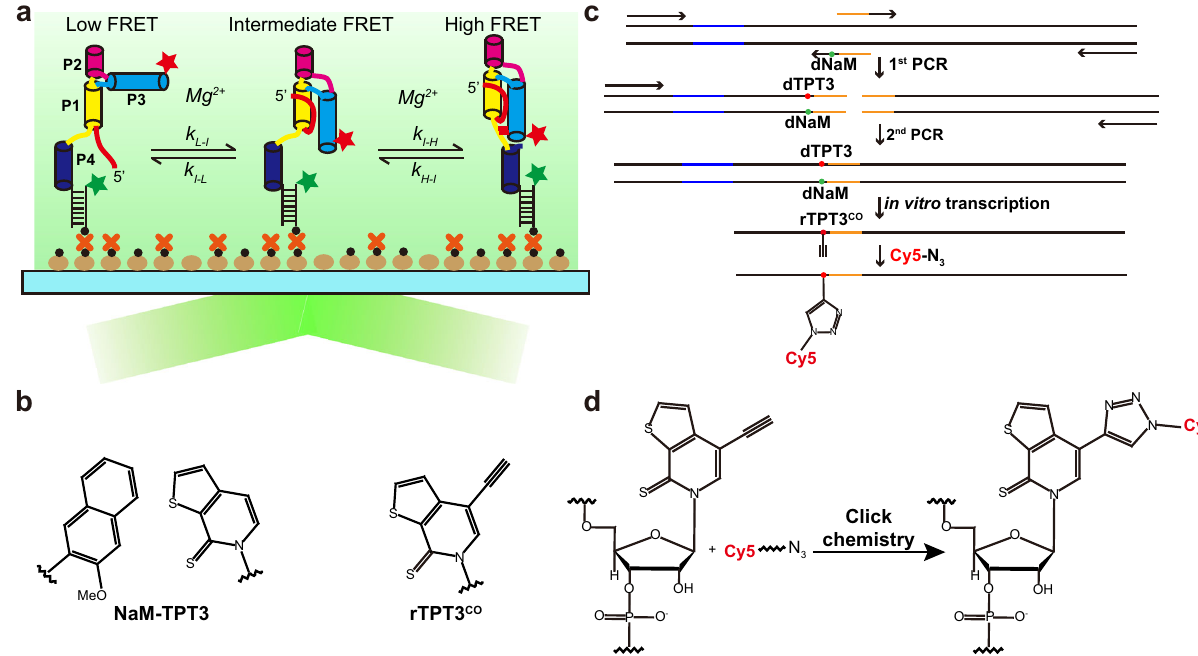
Fig. 2 UBP-based strategy for RNA fl uorescent labeling facilitates TIRF-based smFRET measurements of fl aviviral xrRNAs. a Schematic representation of the TIRF-based smFRET analysis of the folding of fl aviviral xrRNAs. The low-FRET ( L state ), intermediate-FRET ( I state ), and high-FRET ( H state ) states correspond to the unfolded, partially folded, and folded states of xrRNA1, respectively. b Chemical structures of the parental NaM-TPT3 unnatural base pair and alkyne-modi fi ed TPT3 (rTPT3 CO ). c DNA templates of xrRNAs containing T7 promoter (shown in blue) and dNaM modi fi cation at the template strands were prepared by two-steps overlapping PCR, which was followed by in vitro transcription using rNTP mix supplemented with rTPT3 CO TP, allowing site-speci fi c labeling of puri fi ed transcripts with azide-modi fi ed Cy5 dye. d Conjugation of azide-modi fi ed Cy5 with TPT3 CO -modi fi ed RNA via Click